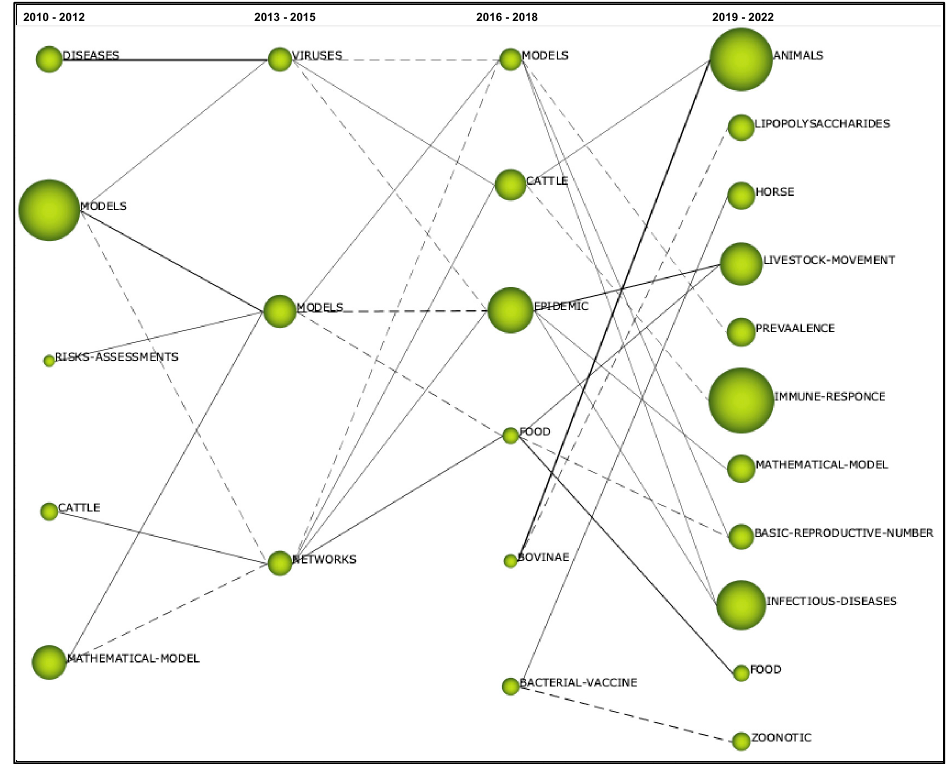
Figure 1. Thematic importance of the relation of infectious diseases and models (term 2010–2022).